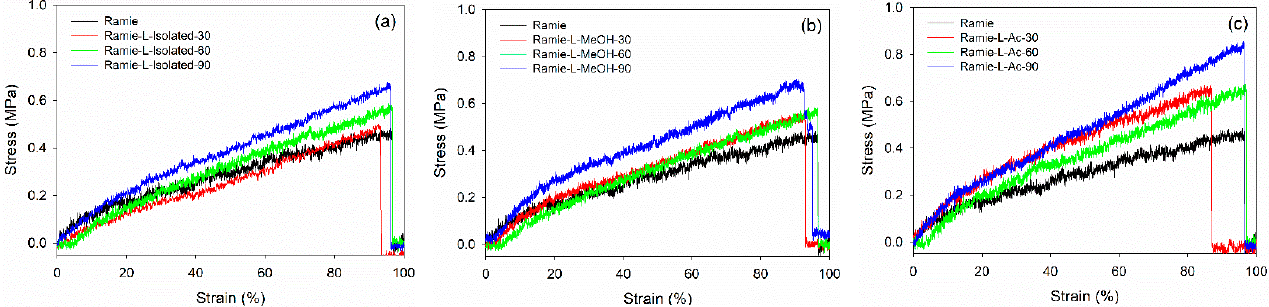
Figure 16. Typical stress–strain curve of ramie fibers before and after impregnation: ( a ) Ramie L ‐ Isolated, ( b ) Ramie L ‐ MeOH, and ( c ) Ramie L ‐ Ac.